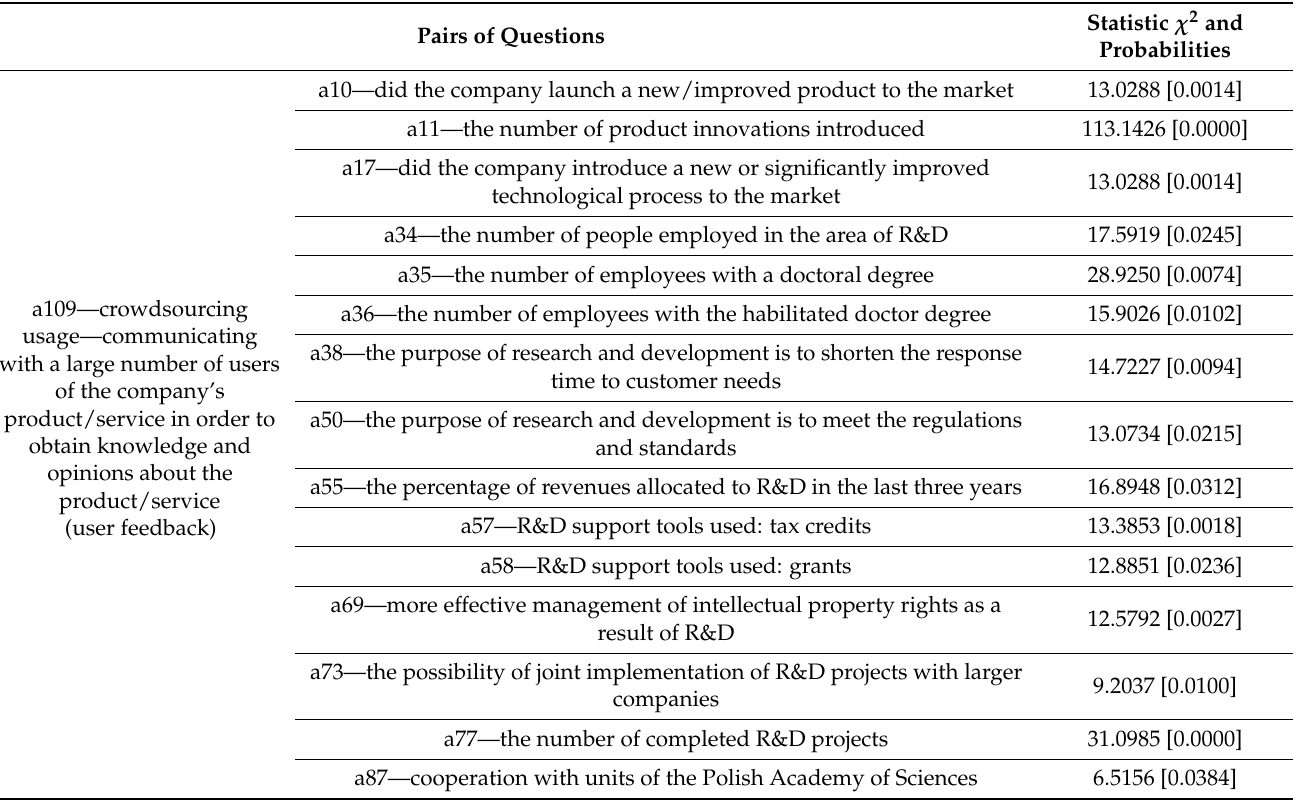
Table 1. The value of the statistics χ 2